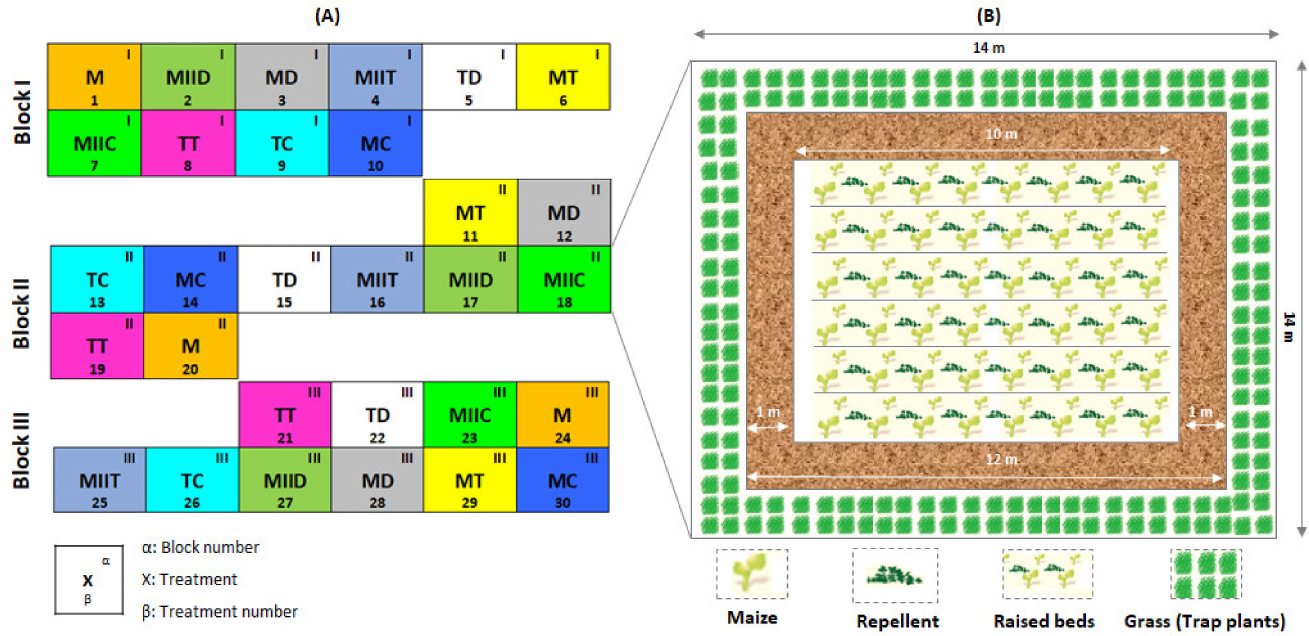
Figure 3. Experimental units ( B ) established in a randomized block experiment ( A ). For abbreviations, see Table